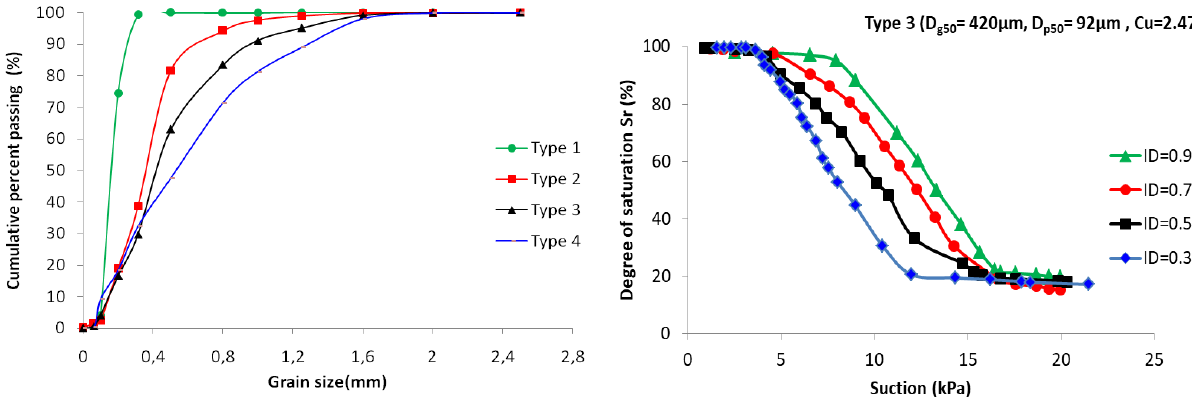
Figure 12: Grain-size distributions of all four sands obtained by sieve analysis.